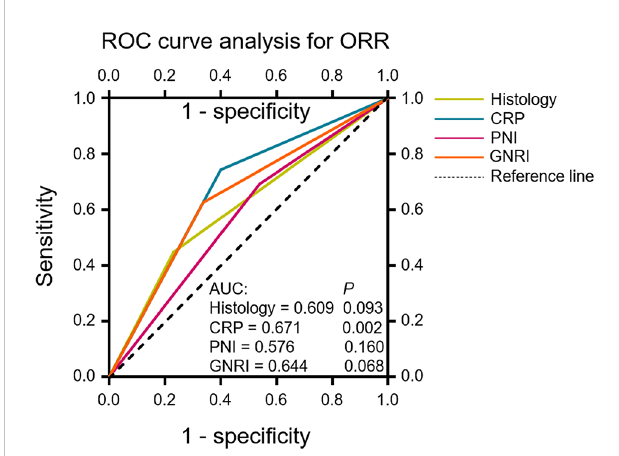
FIGURE 4 ROC curves evaluating the accuracy of the histological type, CRP, PNI and GNRI for response (CR or PR) prediction in patients who underwent tislelizumab treatment. ROC curve analysis was performed to determine the optimal cutoff values and the AUC was used to evaluate the predictive value of the above clinical characteristics. The reference line indicates an AUC of 0.5. ROC, receiver operating characteristic; ORR, objective response rate; CR, complete response; PR, partial response; CRP, C-reactive protein;